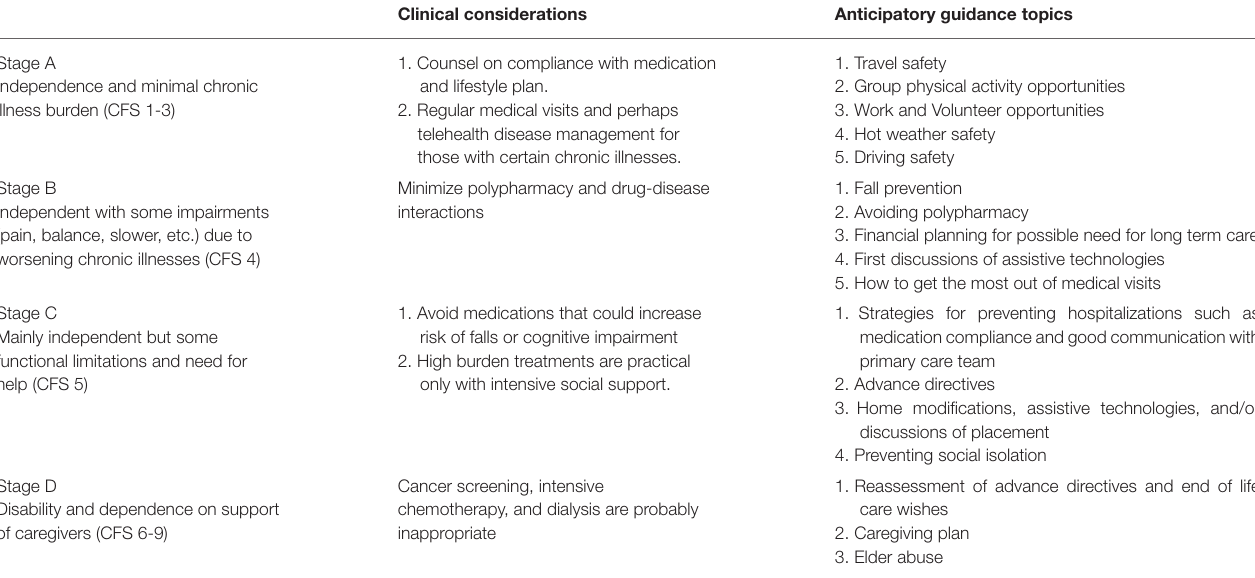
TABLE 2 | Functional age stages with appropriate clinical considerations and suggested anticipatory guidance topics. Clinical